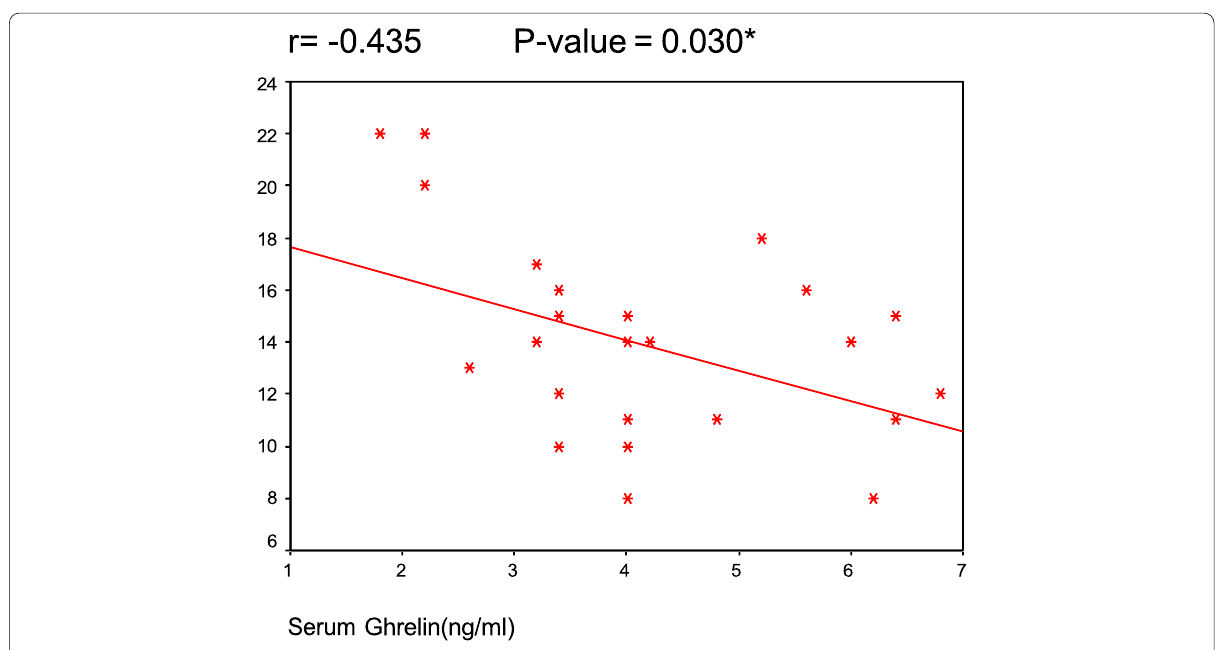
Fig. 1 The significant inverse relationship between severity of depression and serum ghrelin